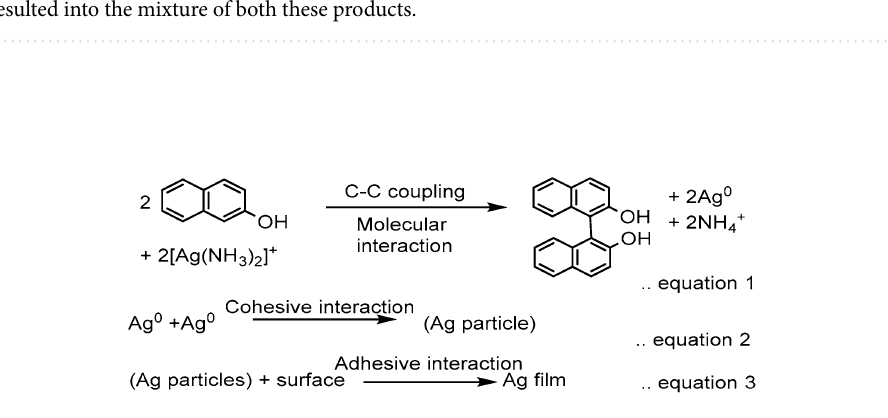
Figure 3. Two distinct Surfaces of a container directing C–C oxidative coupling between 2,6-dimethoxyphenol and 2,6-di- tert -butylphenol to major homo-coupling product (Tef﻿lon TM surface and major cross-coupling product (plastic (polypropylene and polyethylene)—Eppendorf tube). Reaction carried out in borosilicate glass tube resulted into the mixture of both these